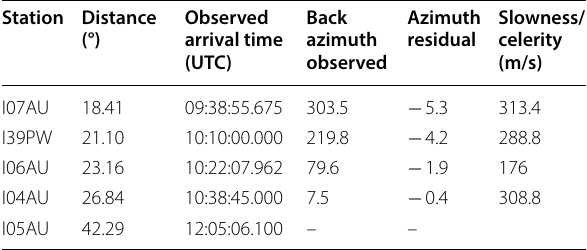
Table 2 Modified results from the CTBTO Reference Event Bulletin (REB) for the Sangeang Api